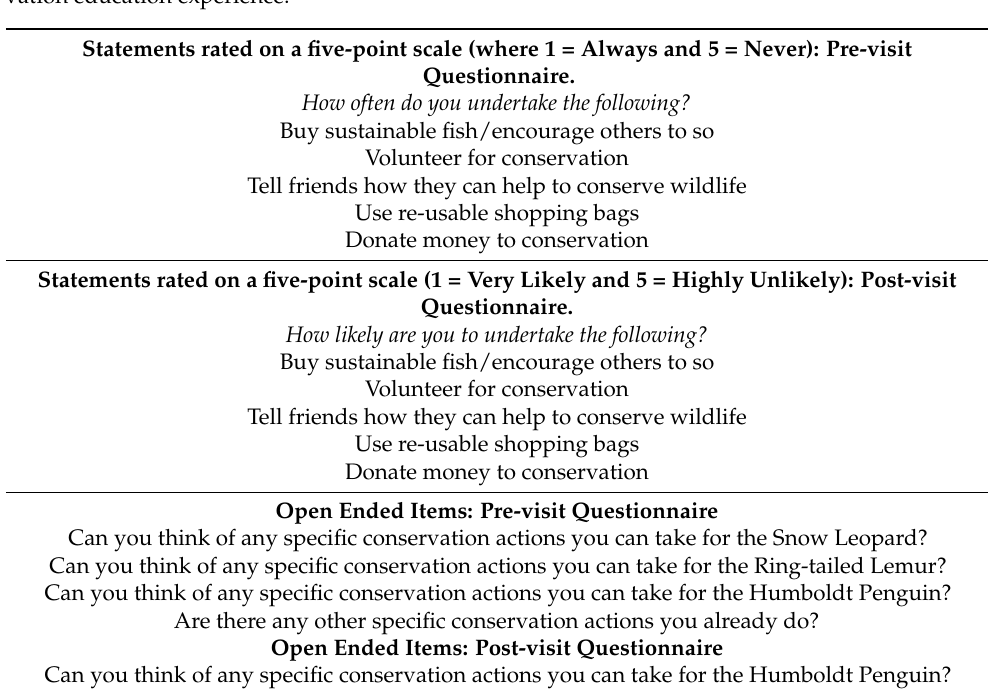
Table 1. Statements in a repeated measure questionnaire used to assess the changes in behavioural intention and conservation action knowledge in visitors to a zoo following a penguin-related conser- vation education